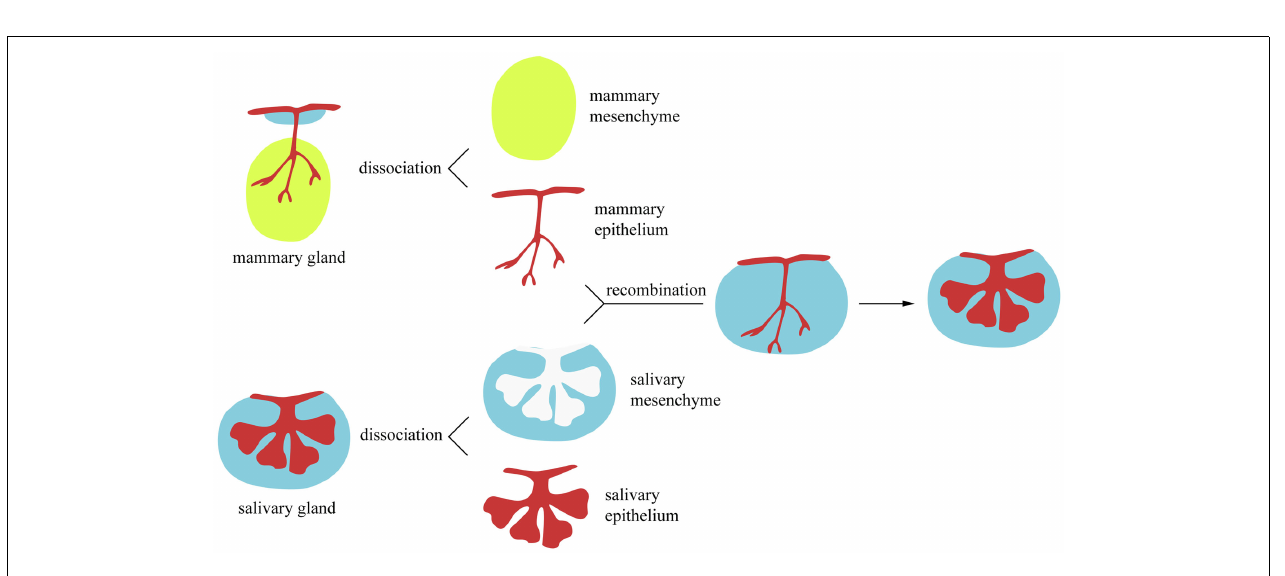
FIGURE 2 | In vitro heterotopic tissue recombination assay. Epithelial and mesenchymal components from ectodermal appendages can be